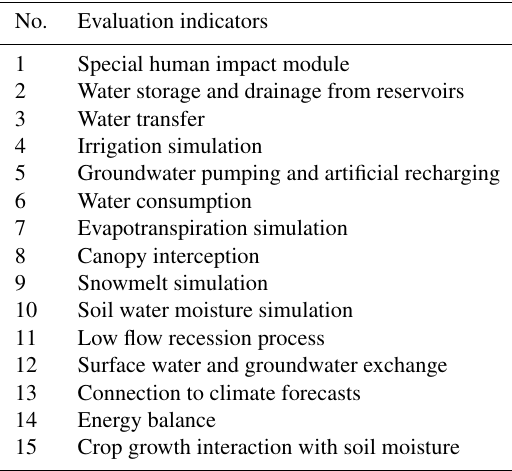
Table 1. Summary of evaluation indicators.